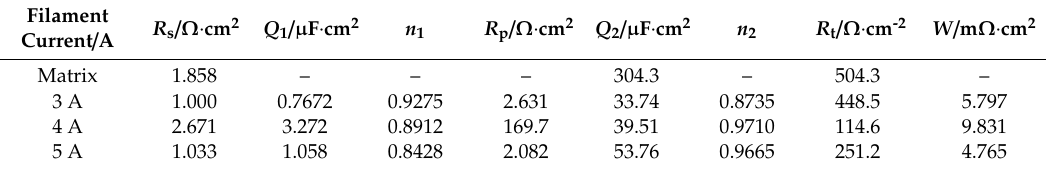
Figure 12. Contact resistances of the CrN x coating under different filament currents.